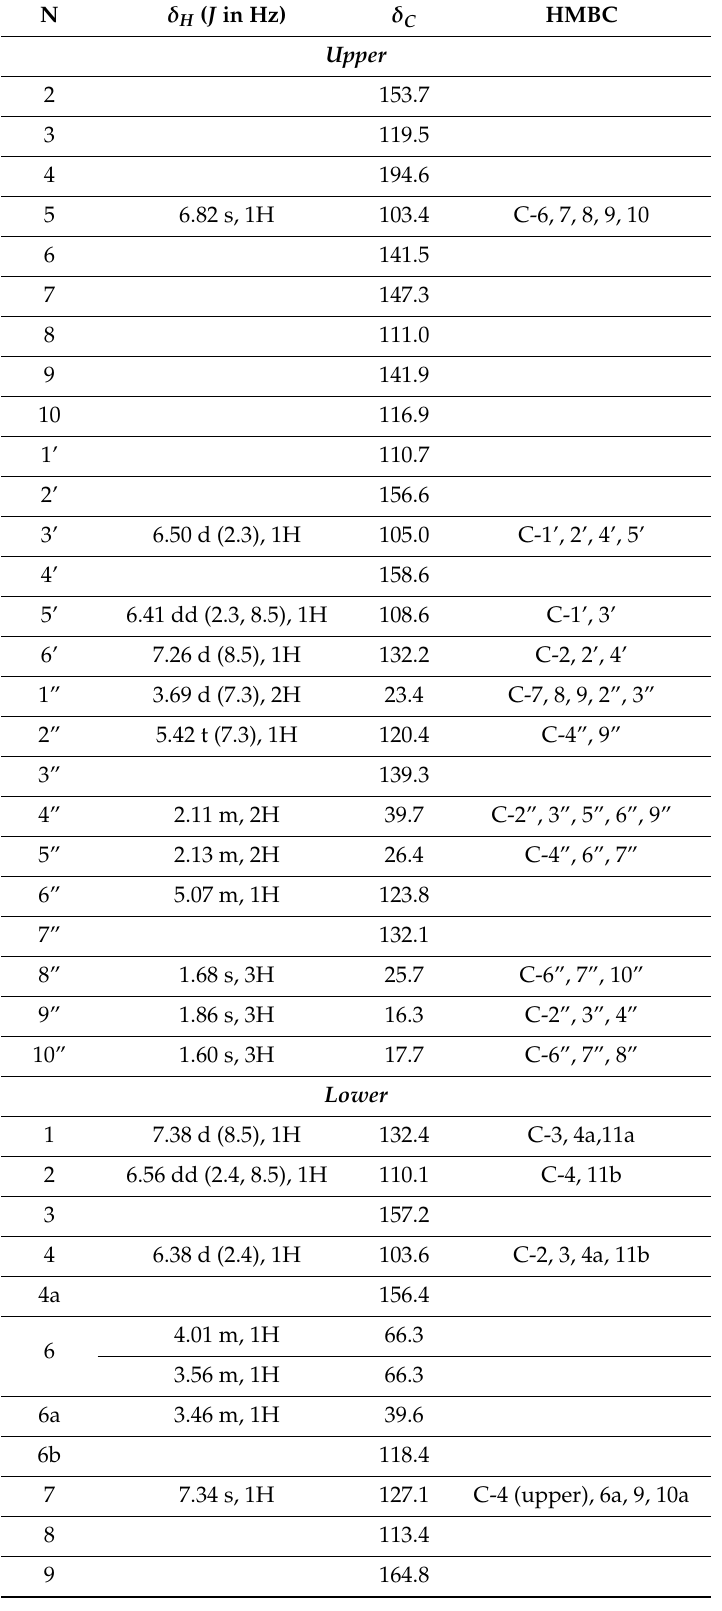
Table 2. 1 H (700 MHz), 13 C (175 MHz) and HMBC NMR data for compound 8 ( δ in ppm, J in